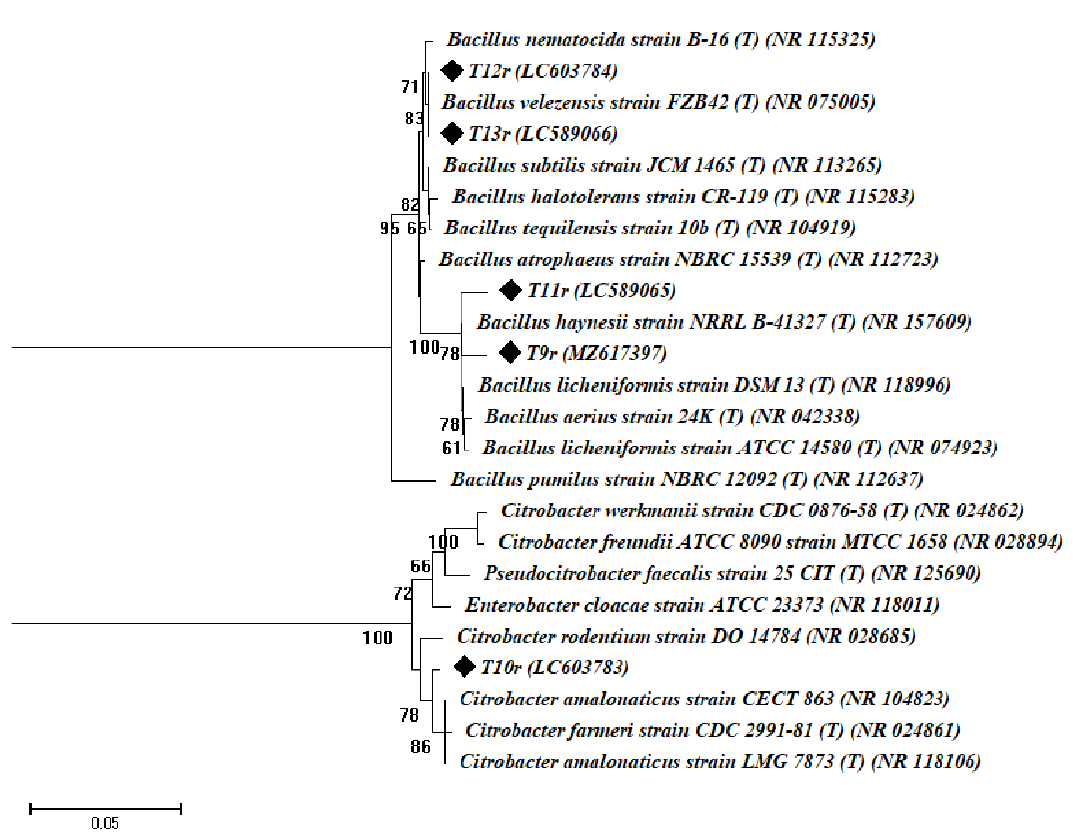
Figure 1: Phylogenetic tree of 16S rRNA sequences for the most potent endophytic bacterial strains isolated from roots of T. vulgaris . The obtained sequences were compared with those retrieved from NCBI. The analysis was achieved by MEGA 6.1 using the neighbor-joining method with bootstrap value (1000